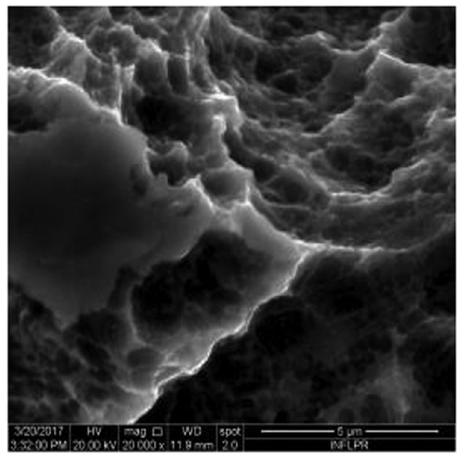
Figure 7: SEM image of sample S7 at a magni fi cation of 20k × .